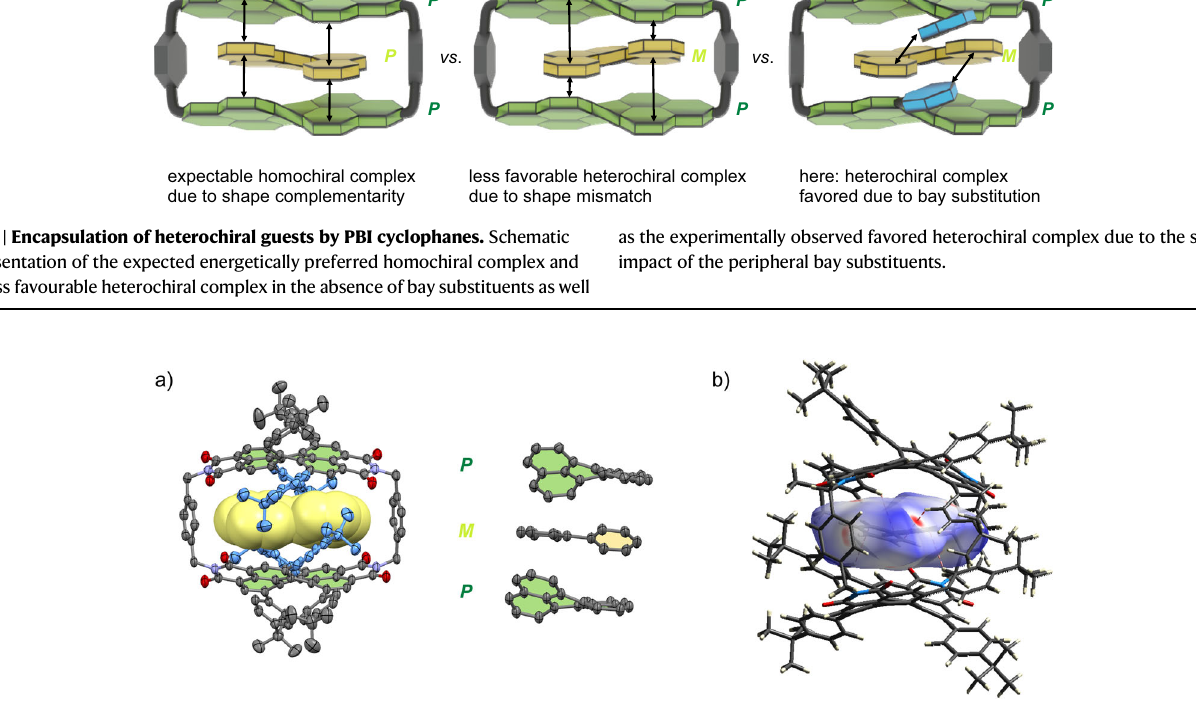
substituents are highlighted in green and blue, respectively. The biphenyl guest is highlighted in yellow. Hydrogen atoms are omitted for clarity (the thermal ellip- soids are set to 50% probability). b Hirshfeld surface analysis to visualize CH- π interactions between the substituents and the guest (close C … H contacts shorter than 2.65Å are highlighted by dashed lines).